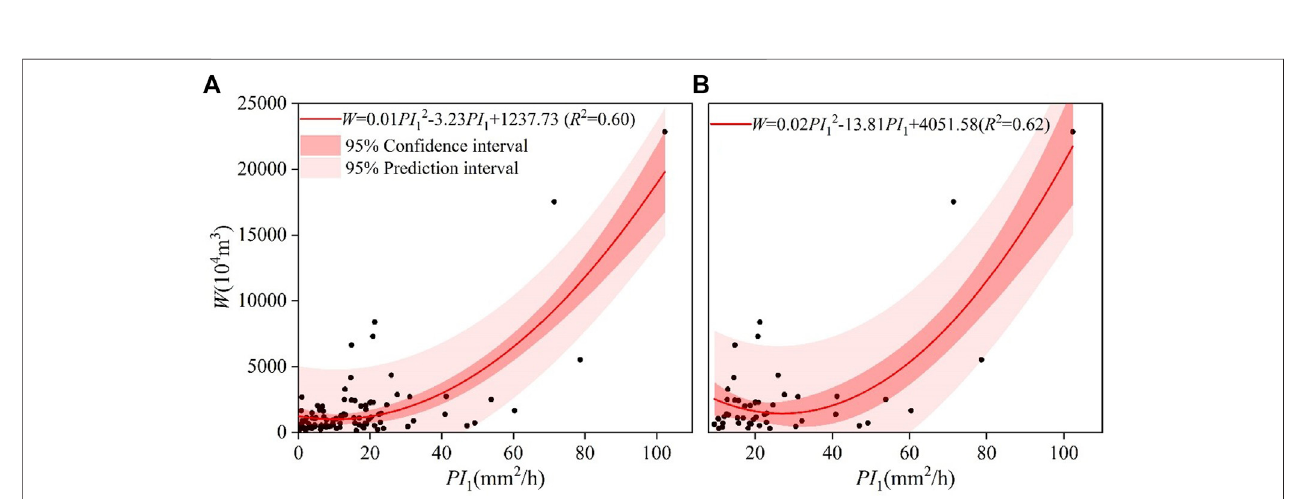
FIGURE 8 | Method of rainfall factor combination fi tting: (A) for all rainfall; (B) for extreme rainfall events.